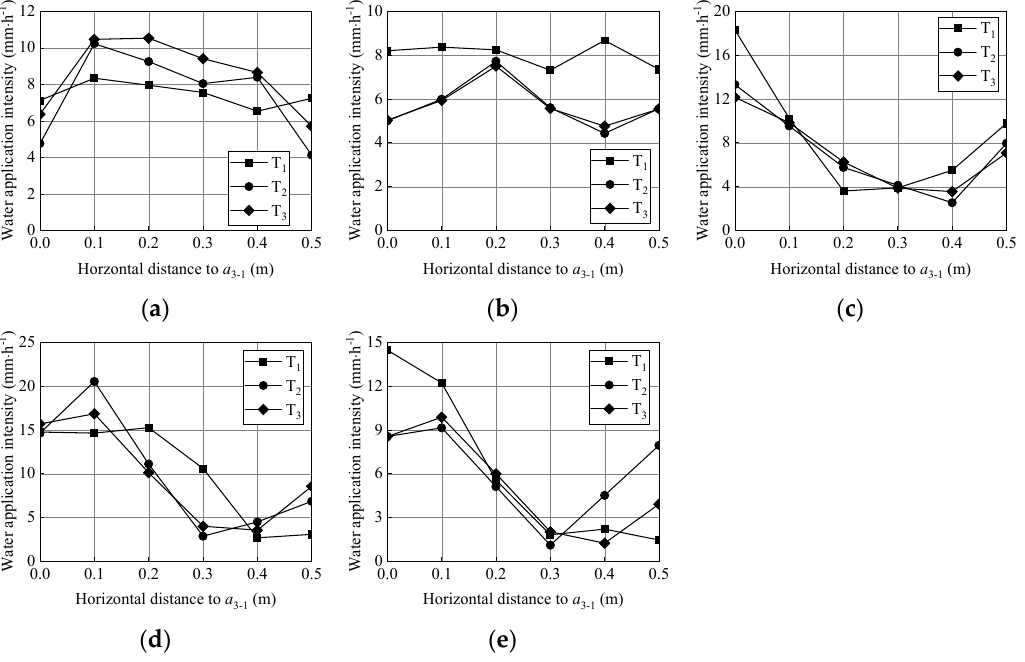
Figure 11. Average water application intensity of single-sided micro-sprinkling hose composed of odd-numbered individual orifices in different test modes: ( a ) y = 0~1 m; ( b ) y = 1~2 m; ( c ) y = 2~3 m; ( d ) y = 3~4 m and ( e ) y = 4~5 m.